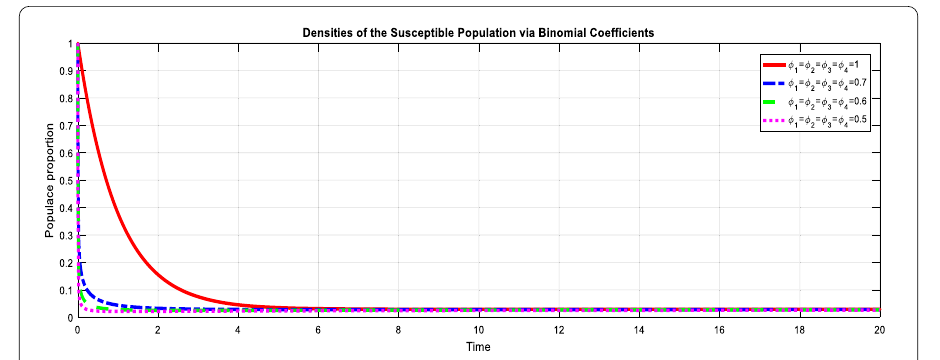
Figure 18 Dynamic of S ( t ) by varying the value of φ